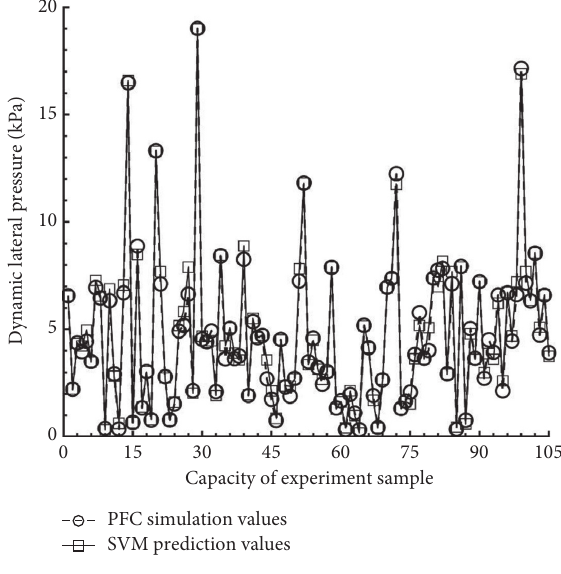
Figure 3: Prediction results of testing samples.